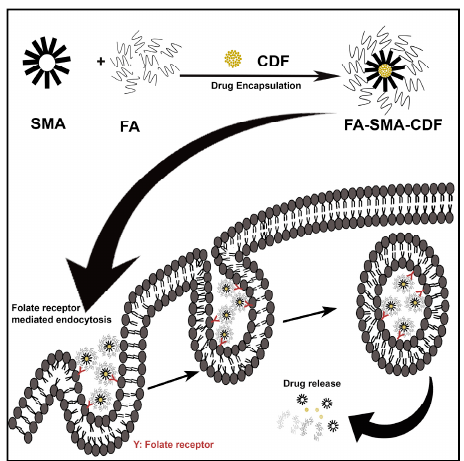
Figure 1. Accumulation of targeted formulation (synthesized amphiphilic poly(styrene- co -maleic acid)-conjugated-folic acid (SMA-FA)-CDF) at the tumor via folate receptor-mediated endocytosis due to the specific binding of FA to folate receptors overexpressed on retinoblastoma cells (Y-79).